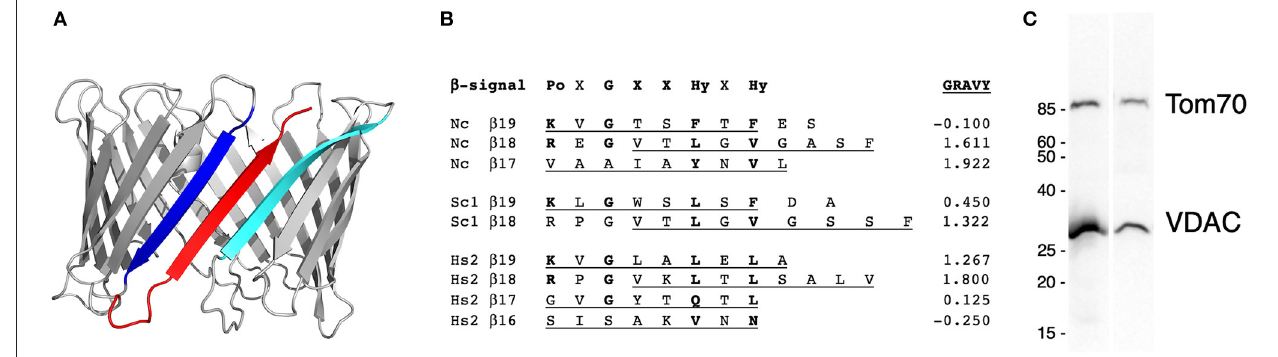
FIGURE 1 | The features and expression of VDAC- 1 C. (A) The structural model of Neurospora crassa VDAC. The model was generated using Phyre2 (Kelley et al., 2015) with human VDAC1 as the template for the entire sequence (PDB: 2K4T), with a 100% confidence score. β -strands β 18 (blue), β 19 (red), and β 1 (cyan) are highlighted. (B) The alignment of the terminal β -strands of N. crassa VDAC (Nc, P07144), Saccharomyces cerevisiae Por1 (Sc, P04840), and human VDAC 2 (Hs2, P21796, and PDB 2K4T). β -strands predicted by the alignment with human VDAC1 (P21796, 2K4T) in Praline (Simossis and Heringa, 2005) are underlined. Non-X residues matching the β -signal motif (Kutik et al., 2008) are indicated in bold. The grand average of the hydropathicity [GRAVY (Gasteiger, 2006)] score, obtained from https://web.expasy.org/protscale/ is indicated in the right column. Po, polar; X, any residue; G, glycine; Hy, hydrophobic, after (Kutik et al., 2008). (C) The Western blot analysis of mitochondria isolated from the wild-type strain (FGSC 9718, left lane) and the strain expressing VDAC- 1 C (right lane). The blot was probed with antibodies against VDAC and Tom70, a component of the protein translocation machinery of the outer membrane (see Supplementary File 1 for details). Size markers on the left are in